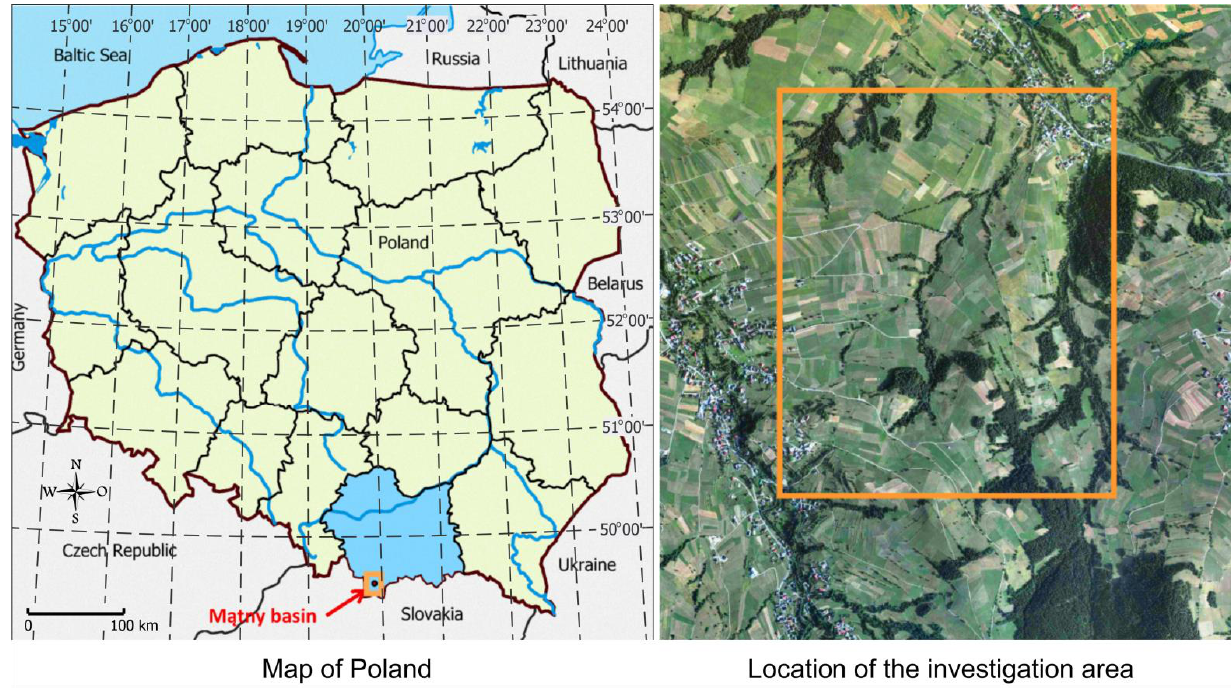
Figure 1. Location of the research area within Poland.